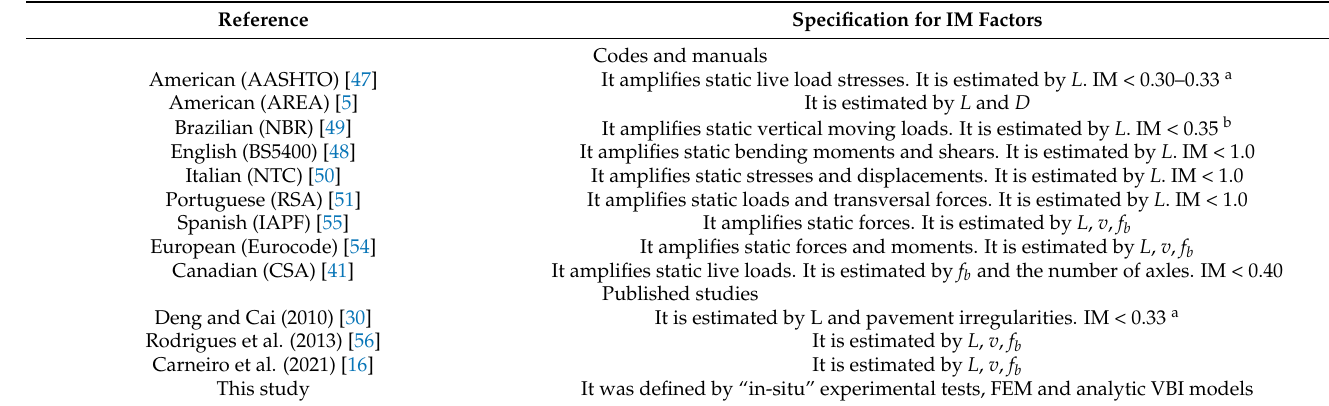
Table 4. Some approaches for estimating the IM